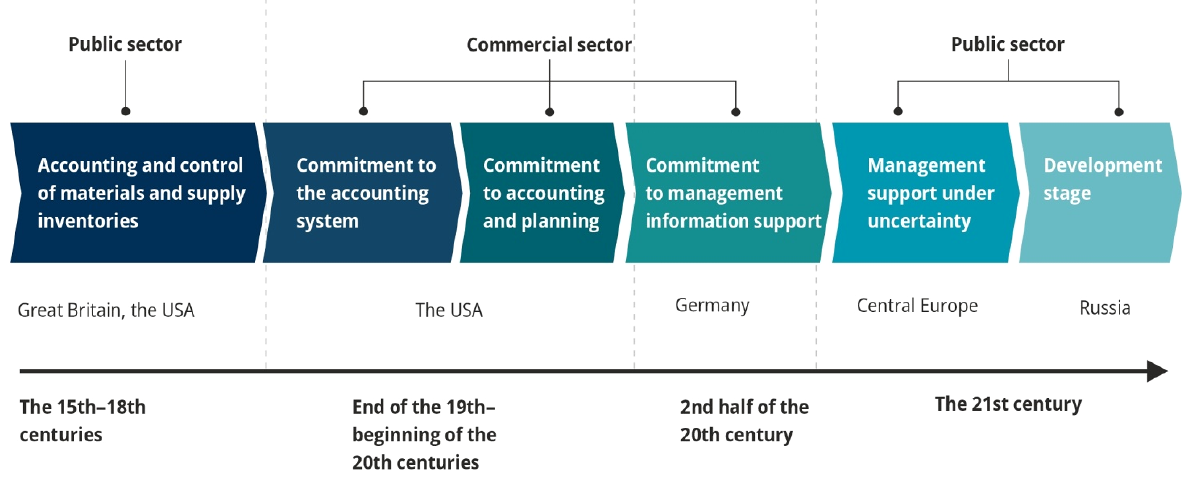
Figure 1. The evolution of the theory of controlling Table 1 gives a comparative description of the American, German and Russian schools of controlling. Table 1. Comparative characteristics of scientific schools of